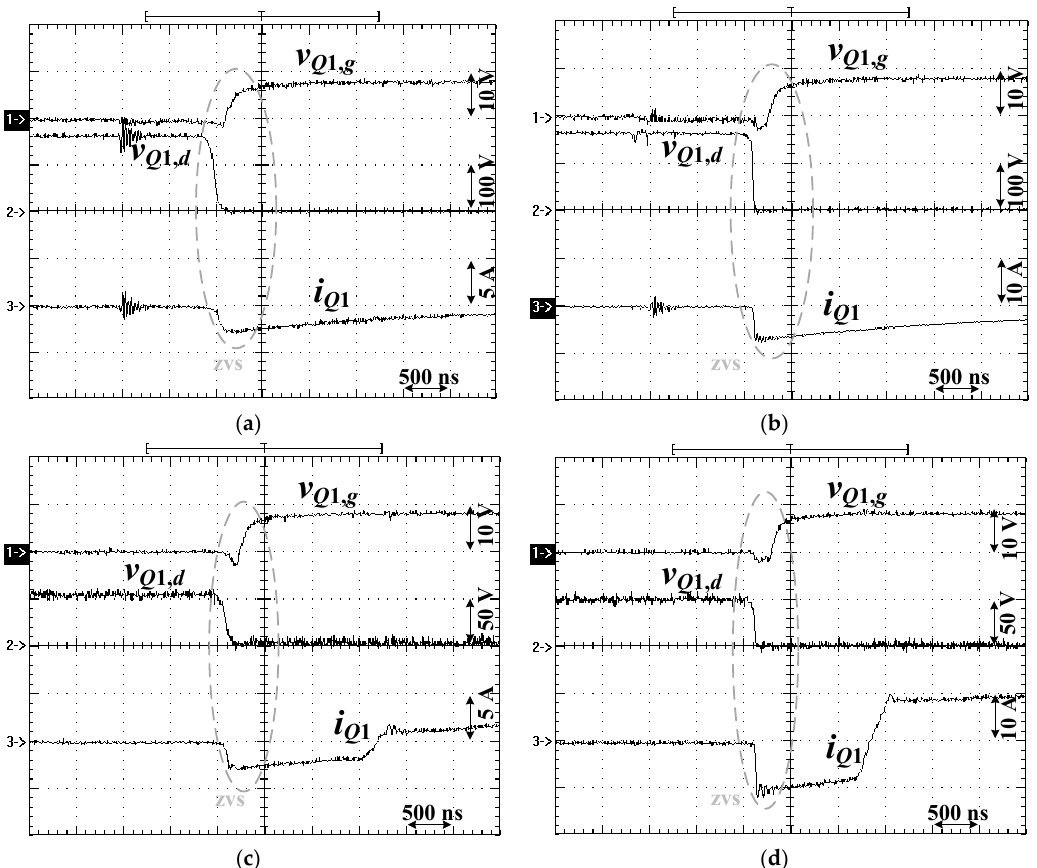
Figure 11. Experimental waveforms of the leading-leg switch Q 1 in high input voltage range at ( a ) 150 V input and 20% load ( b ) 150 V input and 100% load ( c ) 50 V input and 20% load ( d ) 50 V input and 100% load.